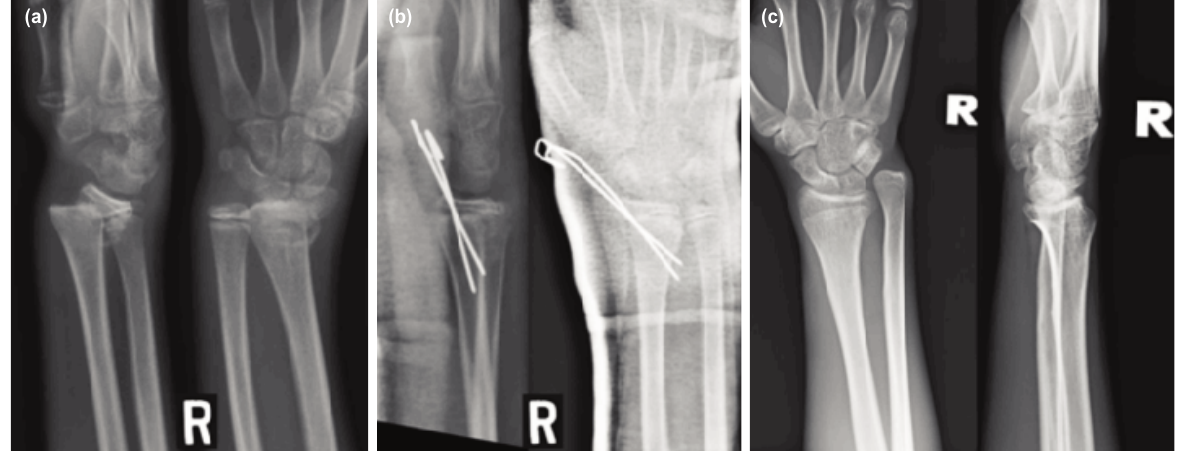
Photo showing (a) the initial fracture of the distal radial physis with dorsal displacement and angulation in one of the children Fig. 4: in this study who was a 12-year-old boy, (b) the physeal fracture was successfully reduced both on AP and lateral views, and was immediately fixed with two smooth K wires to maintain the reduction, and (c) at skeletal maturity, the physeal arrest of the distal radius was observed on plain radiographs manifested by reduction in radial height compared to the ulna on AP view and loss of normal metaphyseal contour of the distal radius subarticularly on lateral view. The metaphysis immediately under the wrist joint appeared short and deformed on lateral radiograph. Despite this, the child had good overall result at skeletal